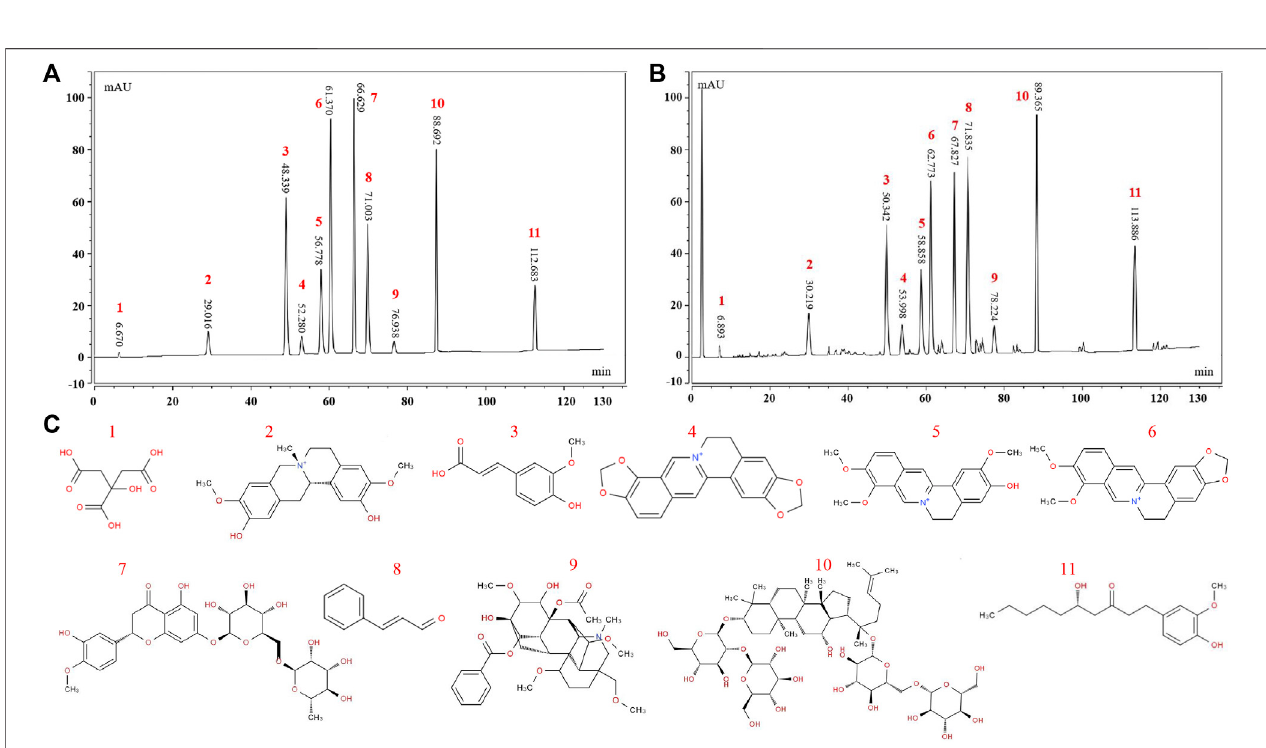
FIGURE 1 | HPLC fngerprinting of WMW. (A) HPLC fngerprint chromatograms of thereference standards (B) HPLC fngerprint chromatograms of the WMW extracts. (C) The structuralformula ofchemical compounds in WMW: 1citric acid;2phellodendrine; 3ferulic acid;4coptisine; 5jatrorrhizine; 6 berberine; 7 hesperidin; 8 cinnamaldehyde; 9 aconitine; 10 ginsenoside Rb1; 11